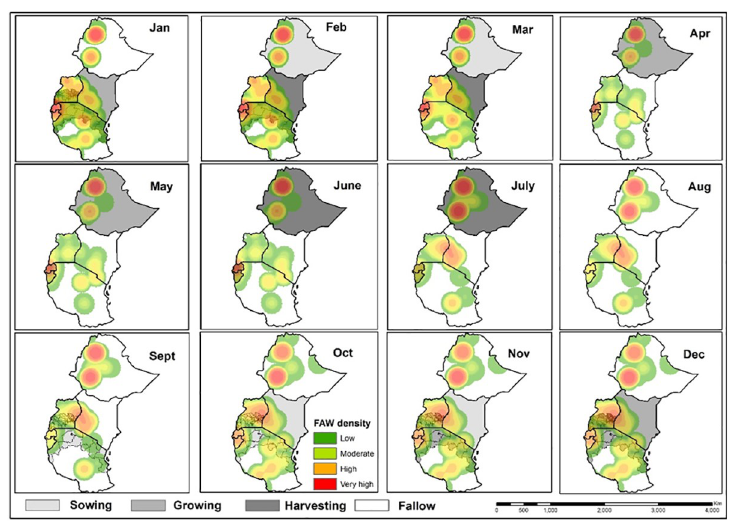
Fig 11. Maize cropping second seasons and fall armyworm trap counts dynamics in eastern